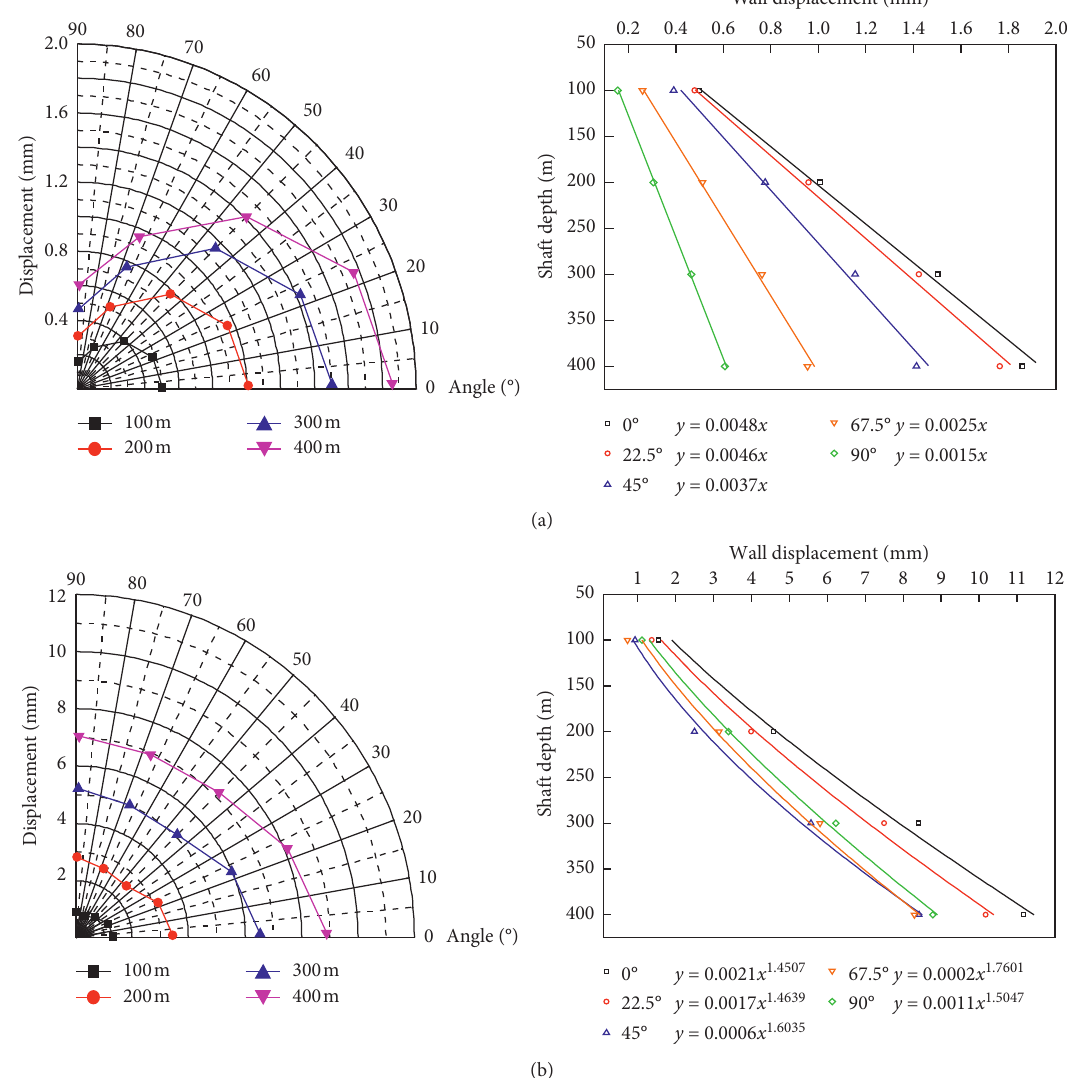
Figure 13: Radial displacement results of different model: (a) No BDZ; (b) BDZ (note the difference in wall displacement scales between the results presented in (a) and (b)).